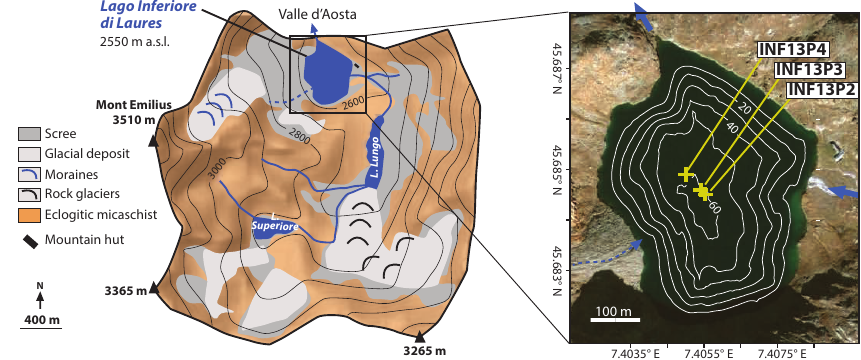
Figure 2. Geological and geomorphological characteristics of the Lago Inferiore de Laures catchment area (left panel). Bathymetric map of Lago Inferiore de Laures and coring sites (right